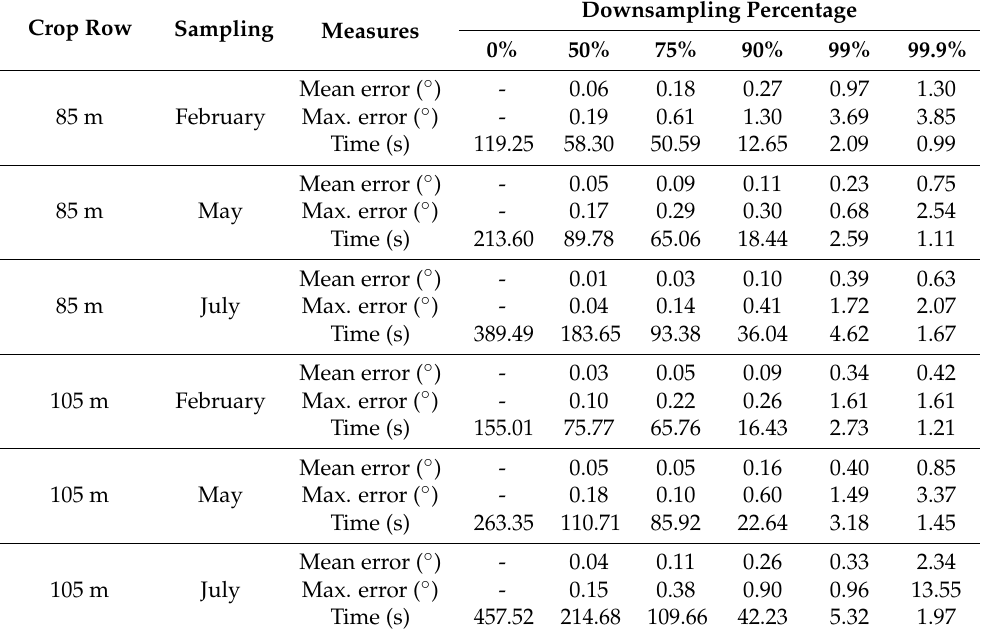
Table 3. Different measures for different downsampling percentages of the point clouds studied.